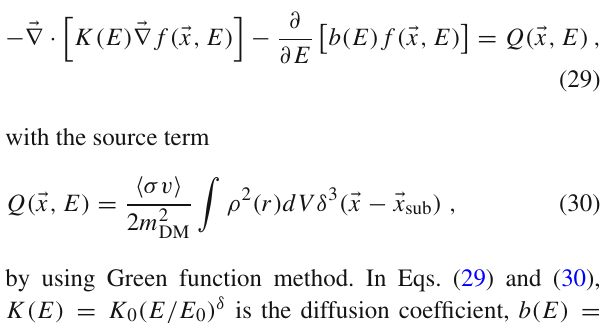
bound respectively. Right: predicted value of current (cid:12) σv (cid:13) in the halo as a function of m Z (cid:3) . The green line satisfy the observed relic density, while the red curves are excluded by PandaX